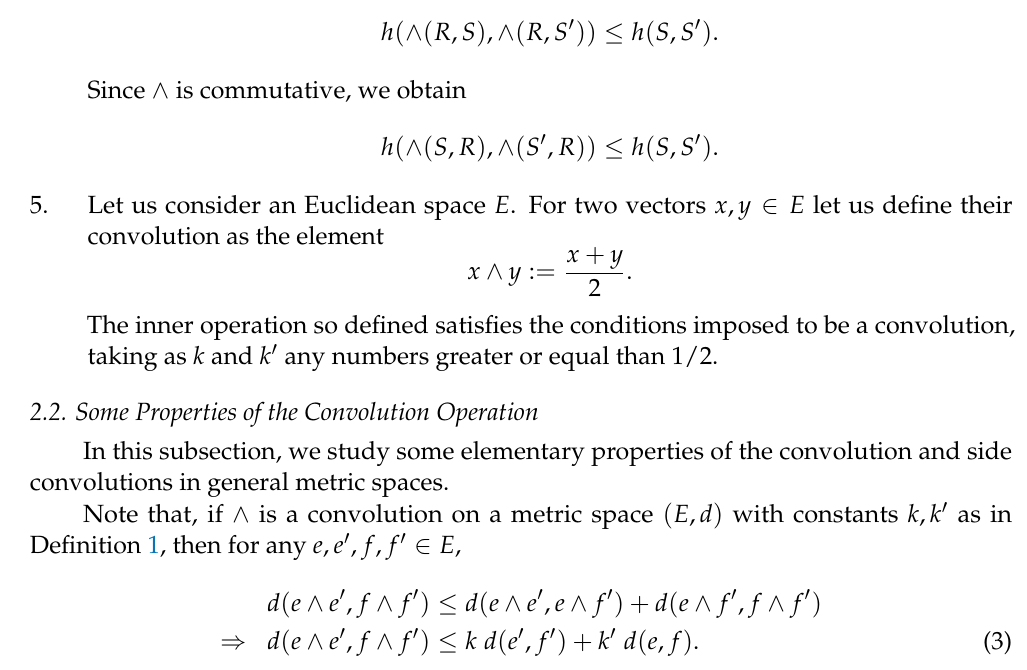
Figure 1 represents the fractal convolution f ∧ b of the functions f ( t ) = e − 5 t cos ( 3 π t ) in the interval I = [ 0, 3 ] . The partition ∆ is uniform with N = 6, and b ( t ) = cos ( π t 2 and the scale functions are the maps α n ( t ) = ( 3 − t ) /10 for all n = 1, 2, . . . , 6. The result is a continuous